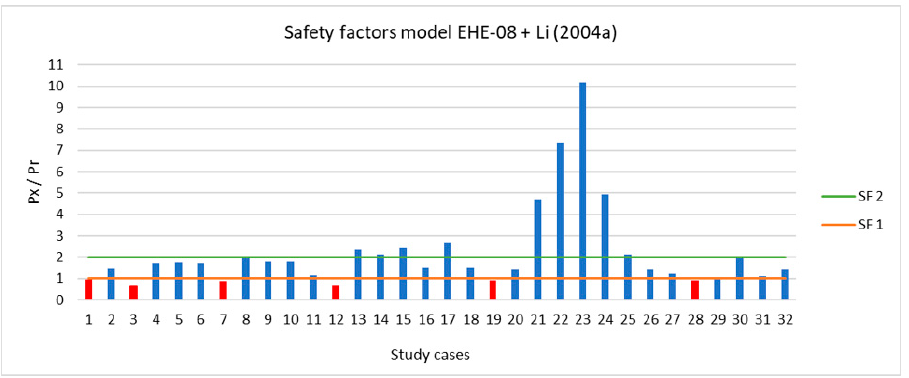
Figure 7. Safety factors obtained for each case study by applying the EHE-08 + Li (2004) model.